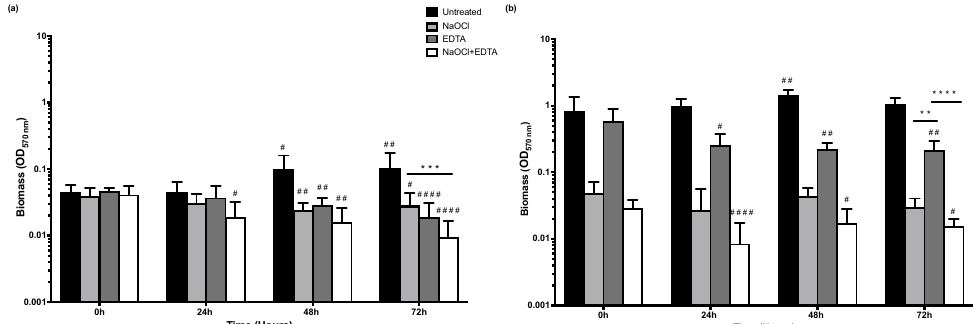
Figure 6. The e ff ect of the three treatment conditions: NaOCl, EDTA and NaOCl + EDTA on pre-formed 24 h biofilms biomass in relation to untreated biofilms. Crystal violet (CV) readings were taken at 0, 24, 48 and 72 h. Values were plotted as log 10 on the Y axis. ( a ) Biofilm biomass for LBF ( b ) Biofilm biomass for HBF. Statistical significance between the three treatment conditions at 72 h was presented as ** p < 0.01, *** p < 0.001 and **** p < 0.0001. Whereas the significant di ff erence in relation to untreated biofilms of the same treatment condition over time was presented as # p < 0.05, ## p < 0.01 and #### p <